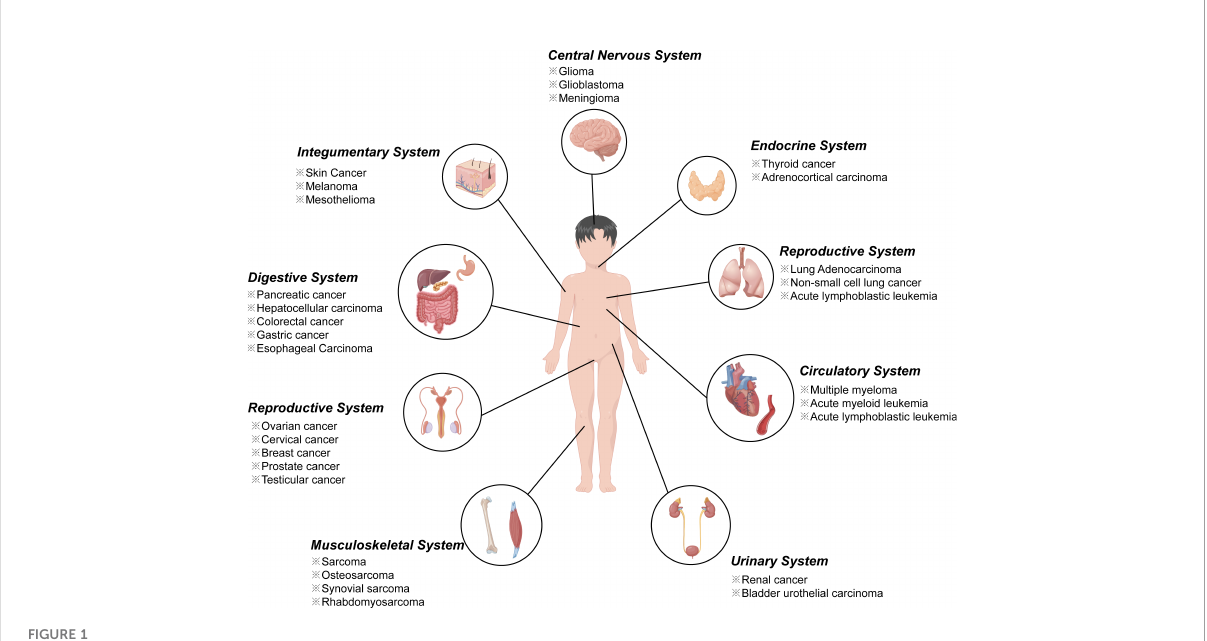
FIGURE 1 Ferroptosis in various cancers from different